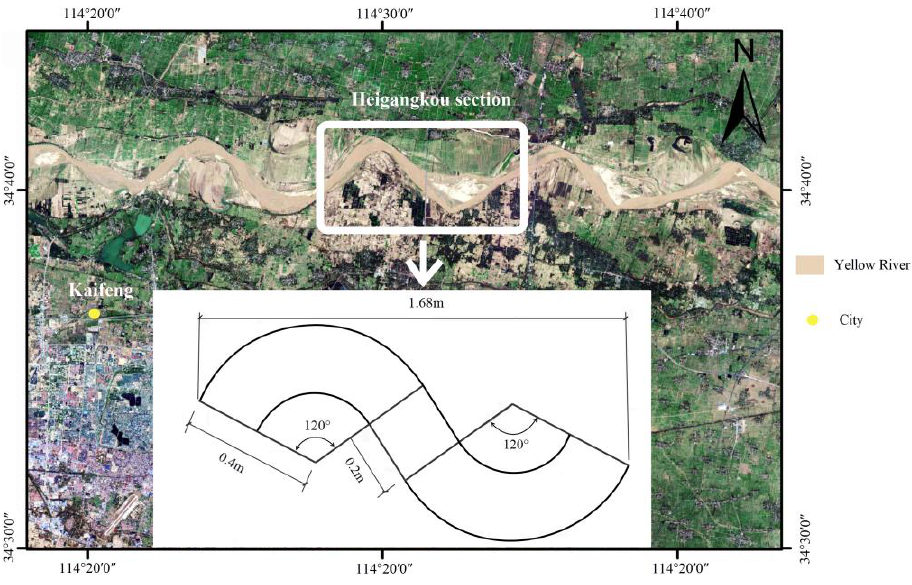
Figure 2. Schematic diagram of flume size.